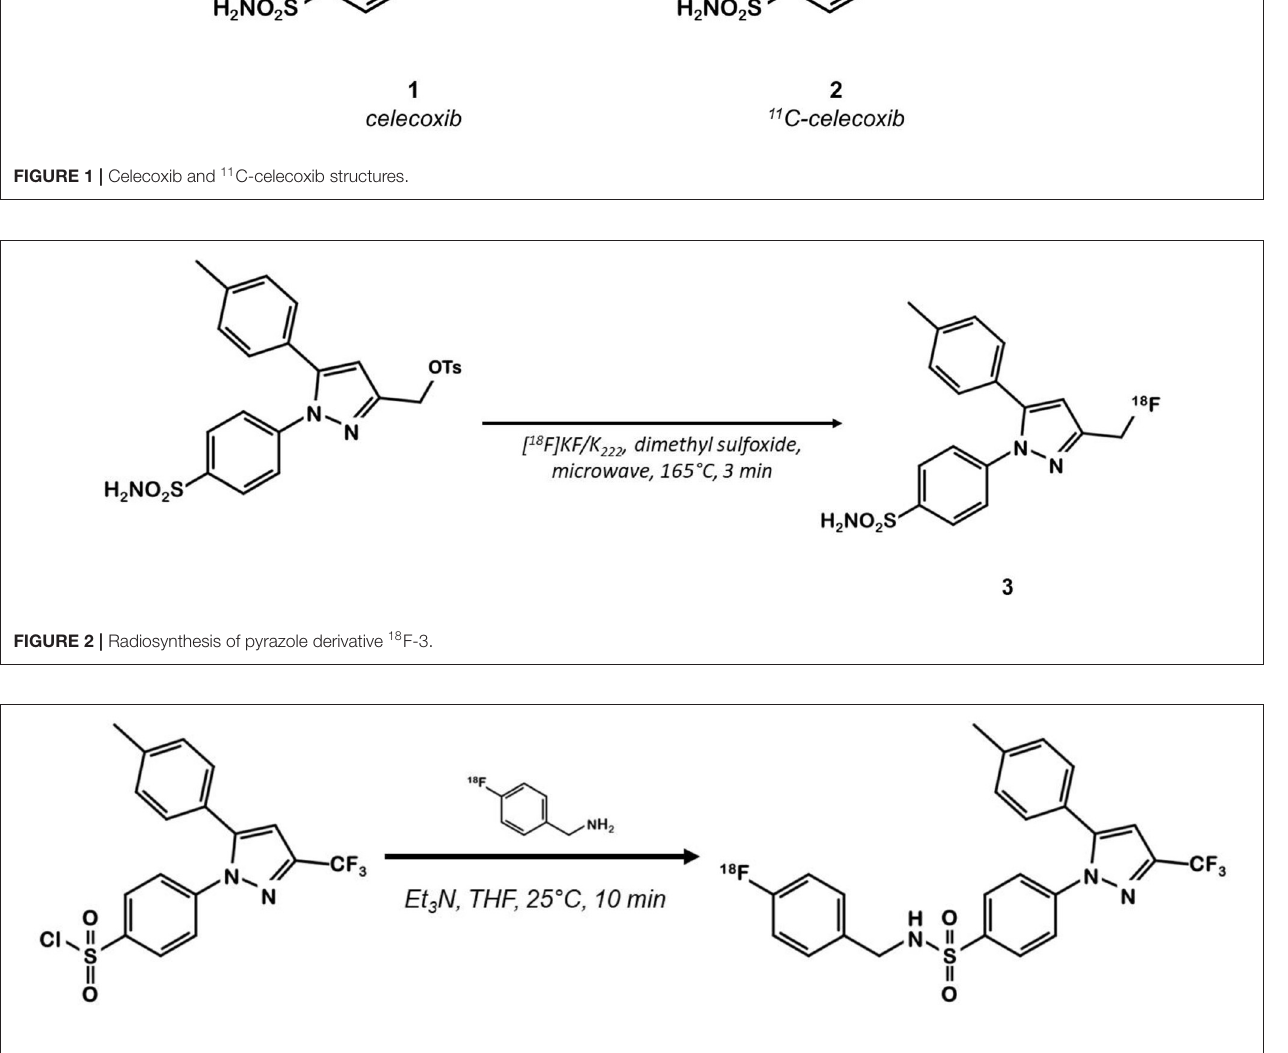
human colorectal adenocarcinoma cell line HT-29 vs. COX-2- RAW264.7). Its lipophilicity of 4.2 enabled it to cross the